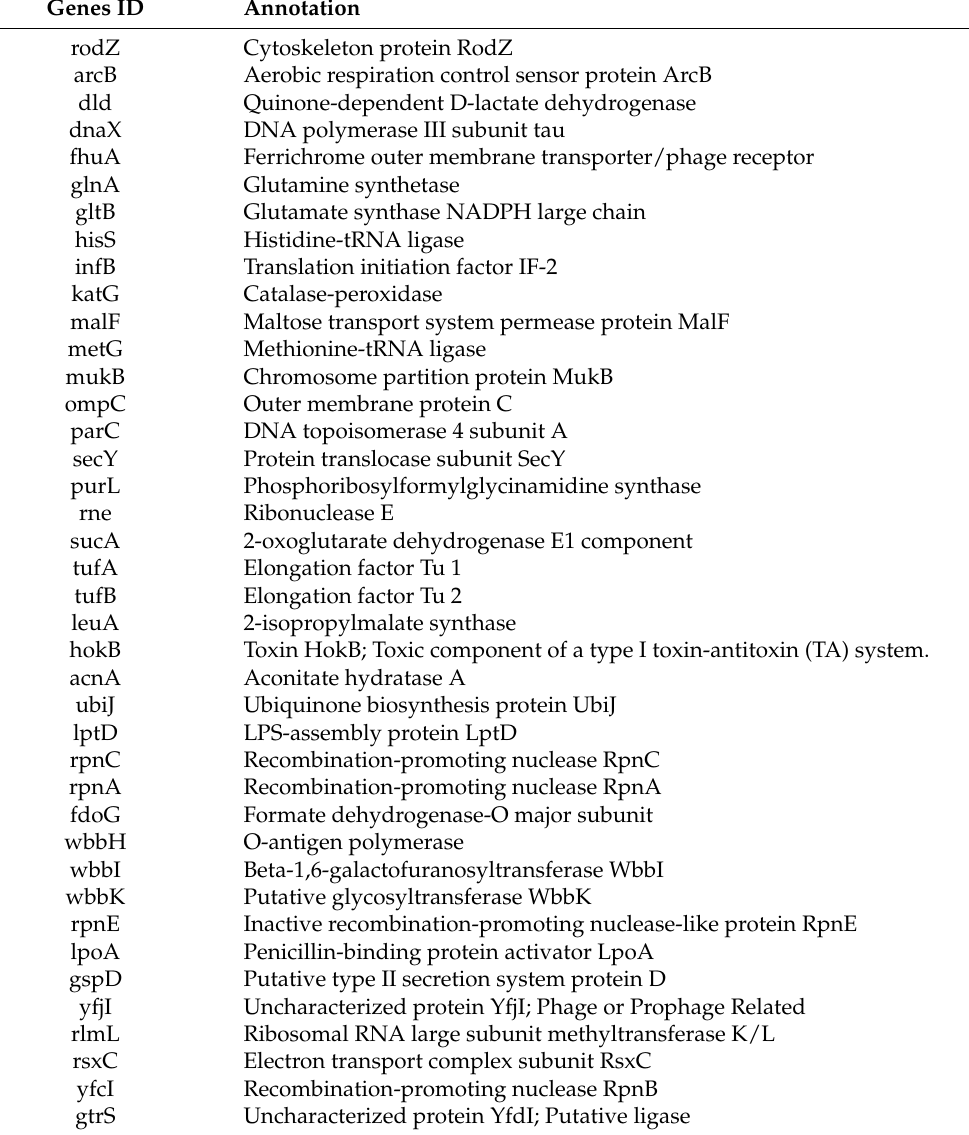
Table 3. Genes with significantly reproducible Ribo–seq profiles across the eight datasets. Column 1: Gene ID. Column 2: